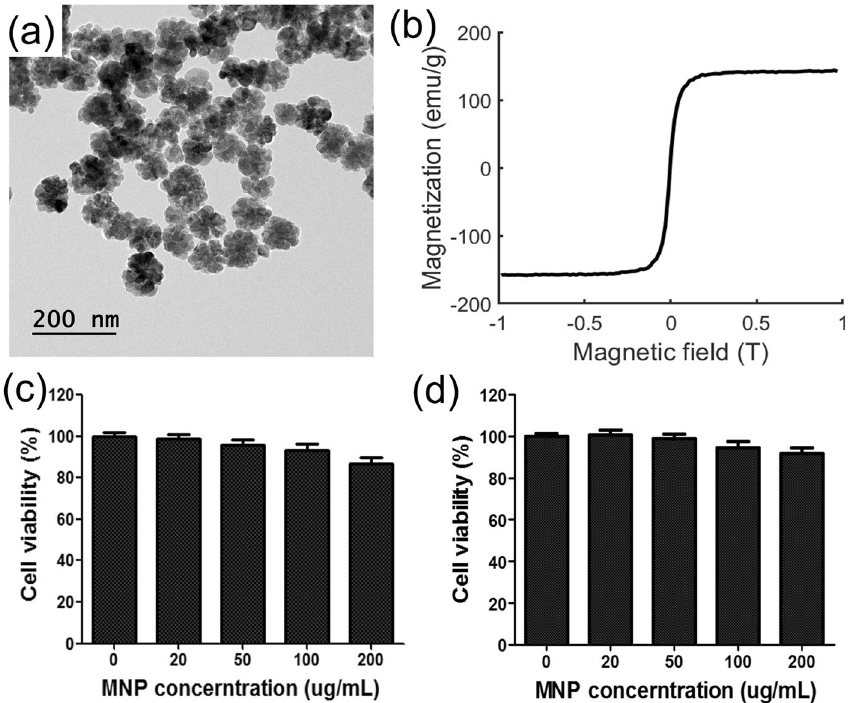
Figure 2. Characteristic and biocompatibility of nanoparticles used for locomotion method. ( a ) TEM image of nanoparticles, ( b ) magnetization curve of fabricated nanoparticles obtained using vibrating sample magnetometer, ( c ) cell viability on NIH3T3, and ( d ) cell viability on 4T1